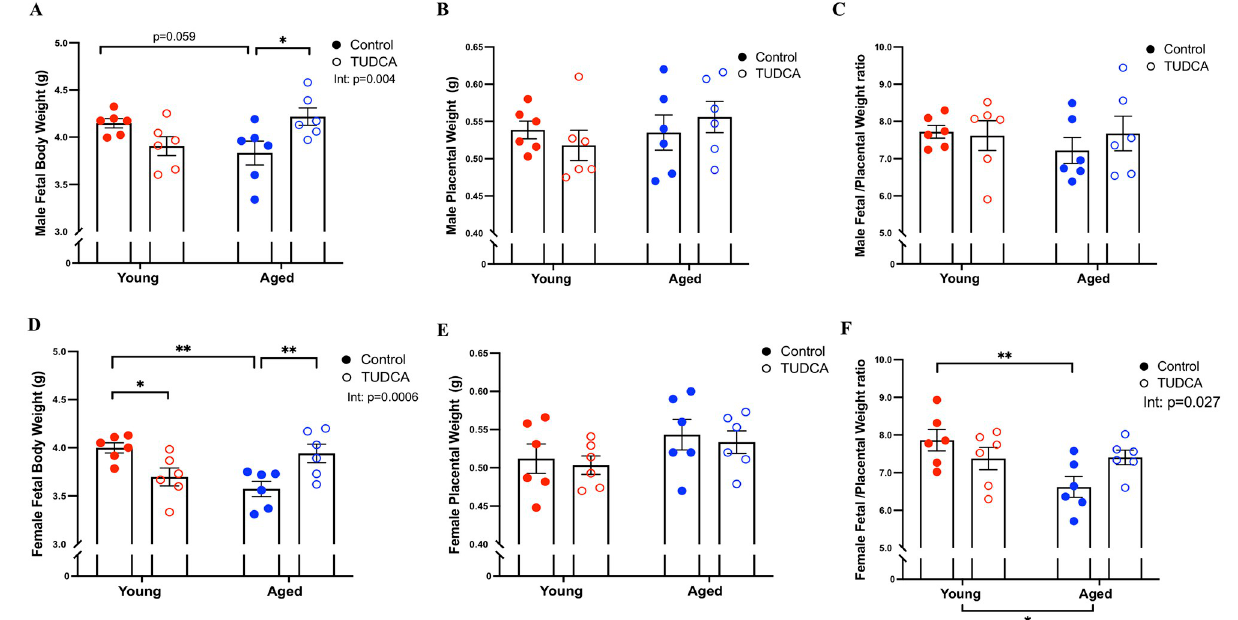
Fig 1. Pregnancy outcomes. Pregnancy outcomes such as (A, D) fetal body weight, (B, E) placental weight, (C, F) fetal/placental weight ratio, in young control (3–4 months; in red) and aged dams (9–10 months; in blue) with or without TUDCA-treatment (open squares) on gestational day 20. Data are presented as mean ± SEM; analyzed by two-way ANOVA with planned contrast post-hoc test; * p < 0.05, ** p < 0.01; n = 6/group.